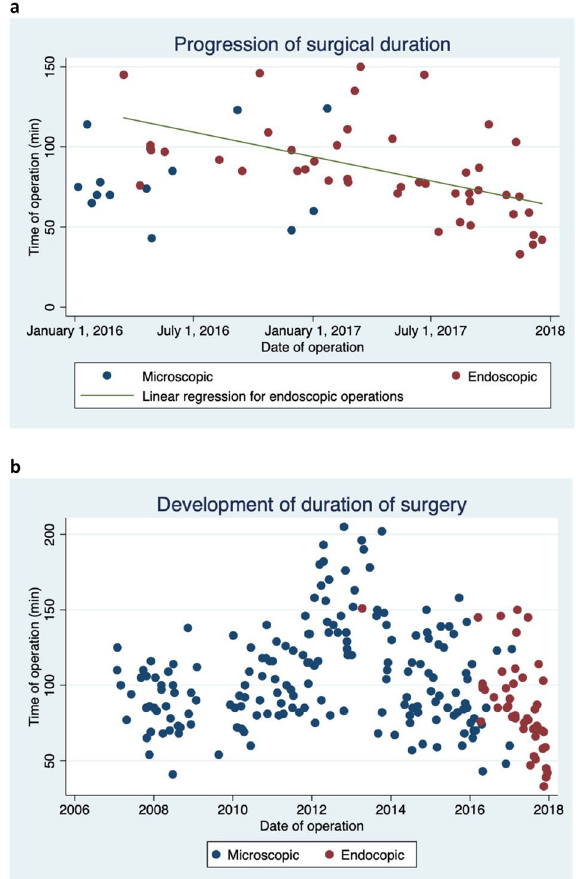
Figure 1. Comparison between endoscopic-assisted and microscopic-assisted surgery for pituitary adenomas. ( a ) The change in duration of surgery from the introduction of the endoscope in 2016, showing a clear learning curve from the start of 2016 to the end of 2017. ( b ) Development in the duration of surgery from 2007 to